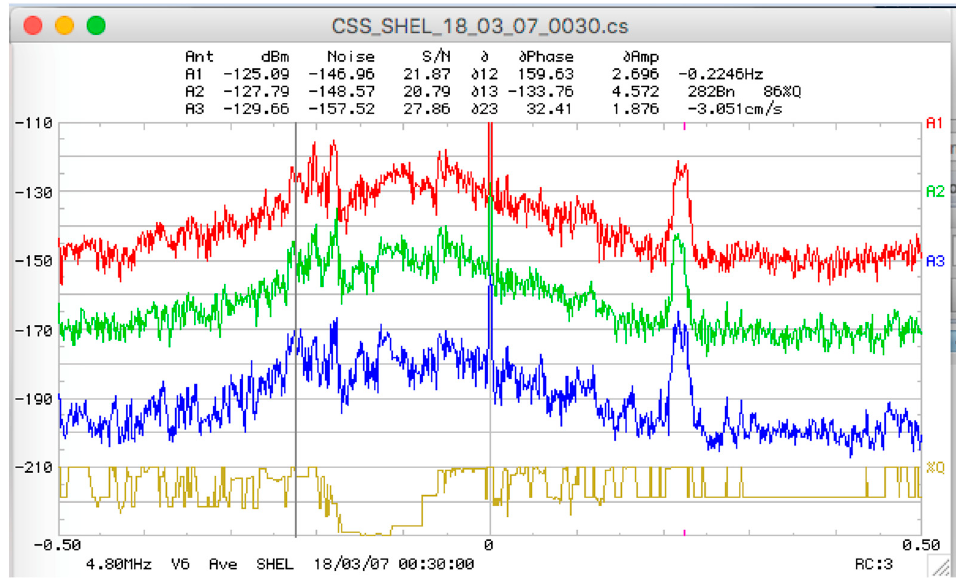
Figure 2. An example of a contaminated radar spectrum, measured at Shelter Cove, California: 7 March, 2018, 00:30 a.m., range 18 km. The radar transmit frequency was 4.8 MHz. For plot details, see the caption of Figure 1.